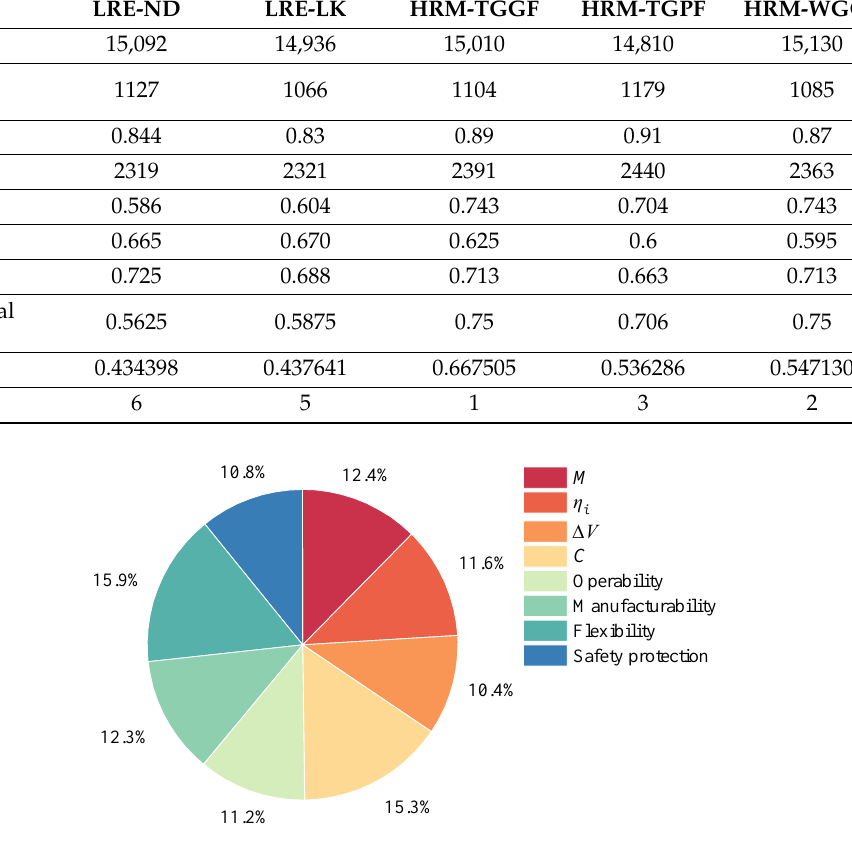
Figure 14. Weight distribution of each attribute.